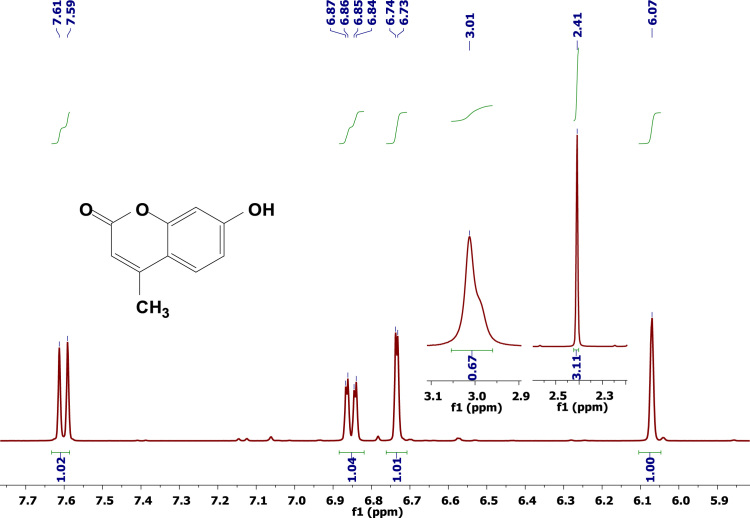
1H-NMR spectrum of 4-Methylumbelliferone (acetone-d6, 298 K, 400 MHz).